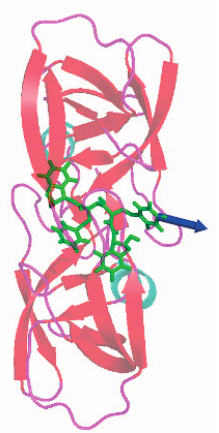
Figure 5. The initial structure of the steered molecular dynamics simulation of 1d4i, and the initial pulling direction is labeled with a blue arrow.